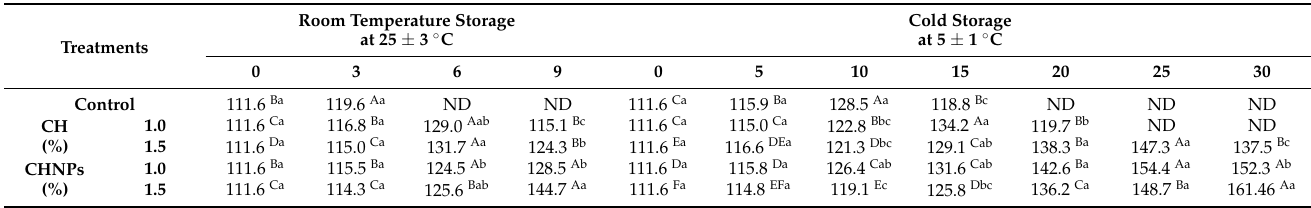
Table 5. Effect of the coatings on the carotenoid content (mg/kg FM) of the apricot fruits.